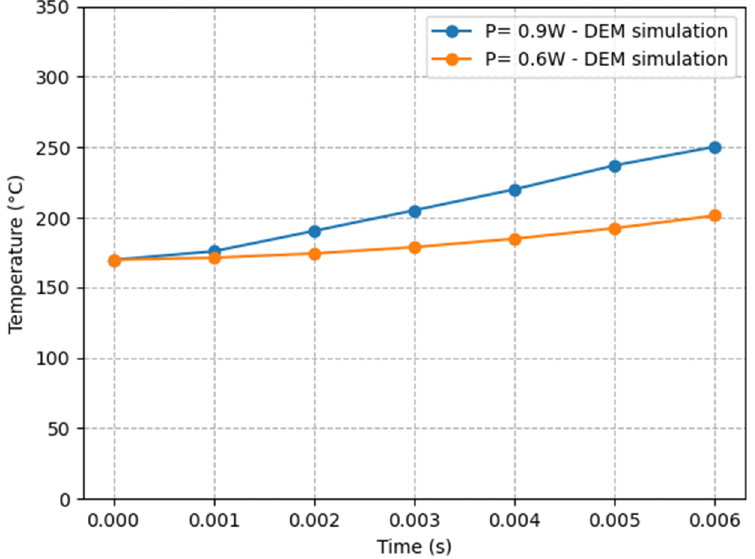
Figure 13. Laser beam center temperature depends on laser scan time and laser power. The temperature evolution of the PA12 powder under two different laser powers is compared in Figure 14 with Lanzl’s experimental study [8].